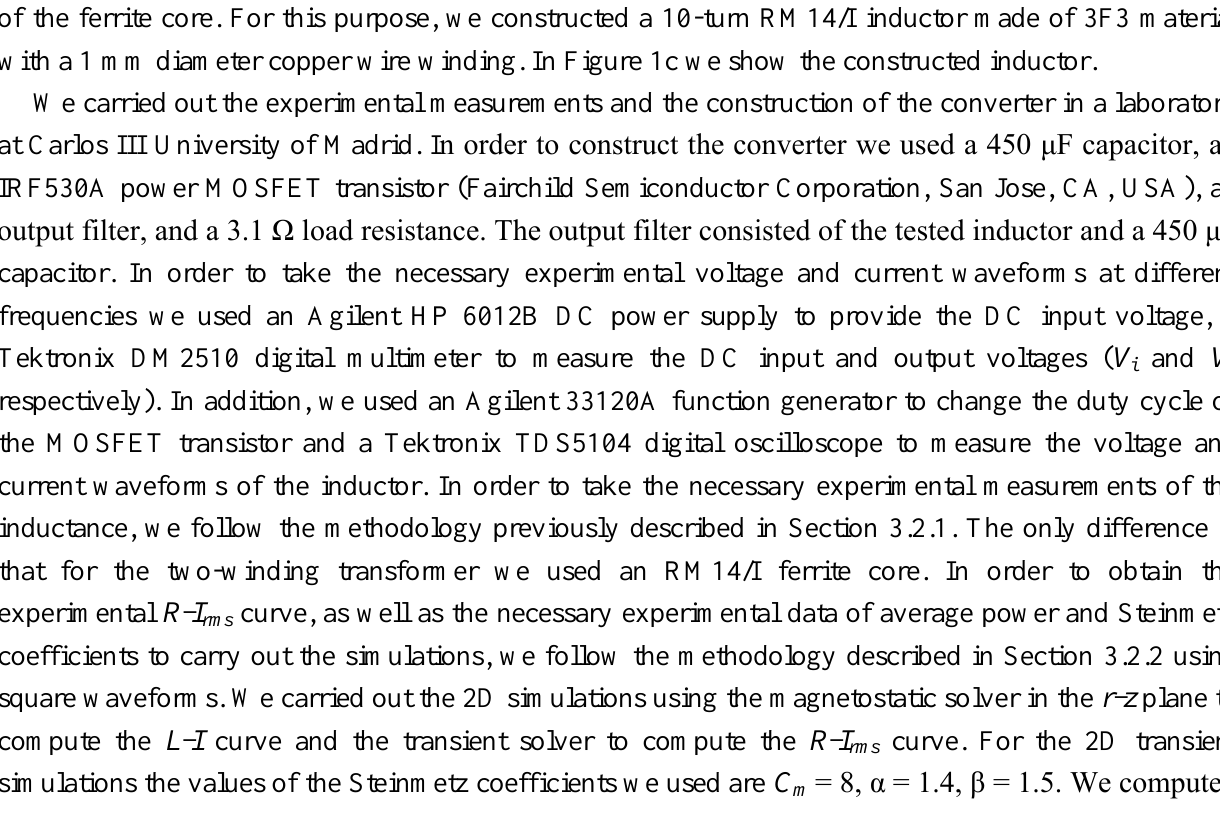
Figure 5. Experimental (-  -  -) and simulated waveforms (  ) at 20 kHz. ( a – c ) V and time step  = 10 −6 s. ( d – f ) V